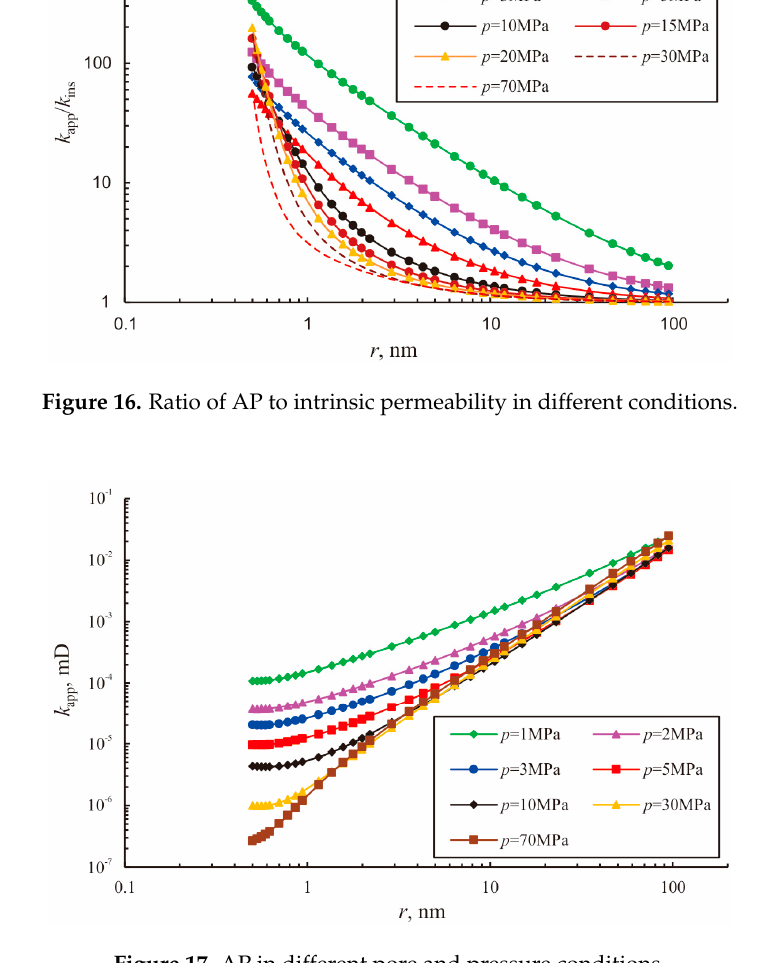
Figure 16. Ratio of AP to intrinsic permeability in different conditions.